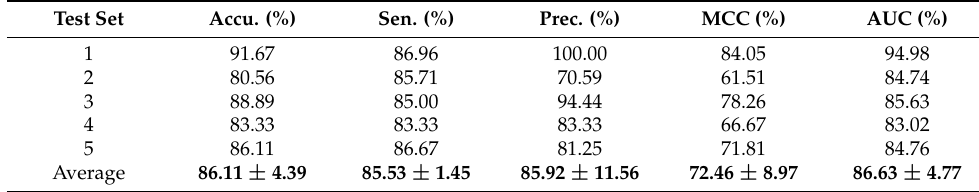
Table 5. MSPEDTI outcomes for 5CV on nuclear receptor